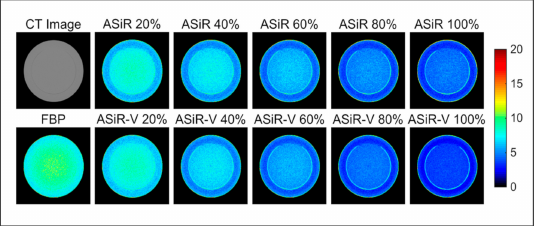
Figure 1. Noise maps (HU) of a CT image of the CTP486 phantom module reconstructed using FBP and ASiR/ASiR-V with different blending levels (20%, 40%, 60%, 80%, and 100%). The corresponding FBP-reconstructed CT image of the phantom is also displayed.